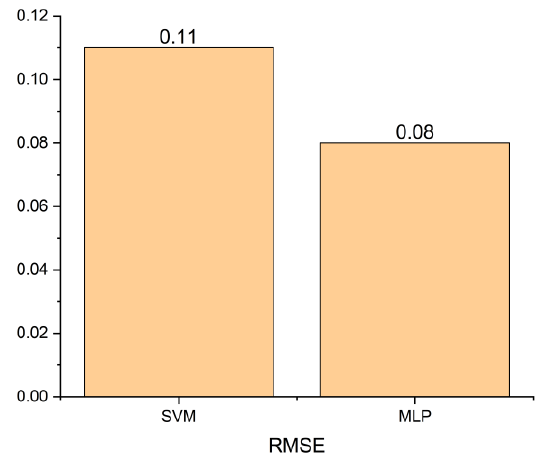
Predicted Data Figure 18. Representation of actual and prediction data for light MLP. The regression performance of the RMSE parameters for both classifiers is depicted in Table 4. It can be observed from Figure 19 that the MLP regressor had a minimum RMSE value as compared with the SVM classifier for the pump, fan, and light control processes. Table 4. RMSE for regression.